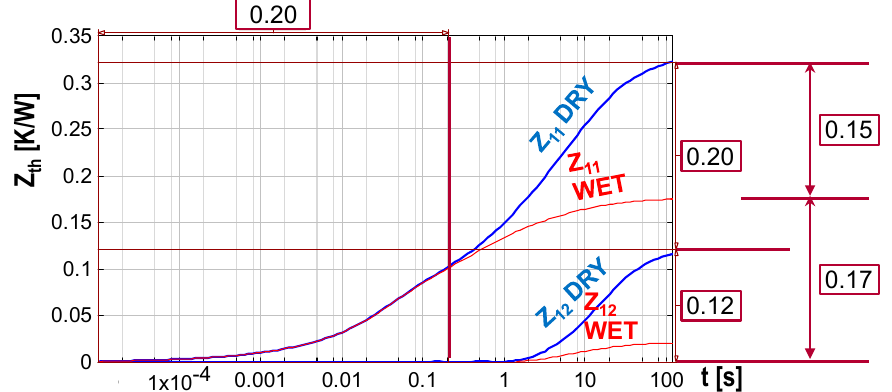
Figure 24. Self- and transfer-heating Z th in the IGBT module (“dry” curves are thick, blue lines, “wet” curves are thin, red lines).